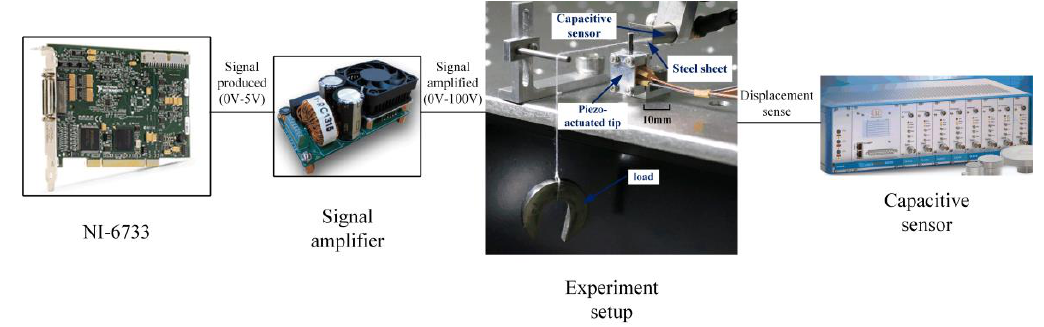
Figure 2. The experimental setup.